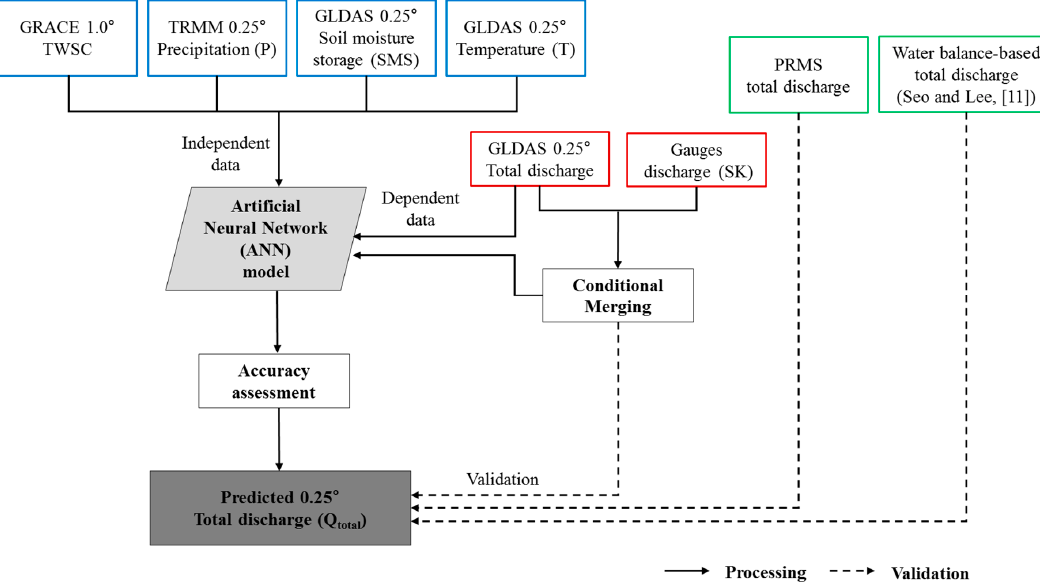
Figure 2. Flow diagram of this research. GRACE: Gravity Recovery and Climate Experiment, TWSC: terrestrial water storage changes, TRMM: tropical rainfall measuring mission, GLDAS: global land data assimilation system, SK: South Korea, and PRMS: precipitation-runoff modeling system.